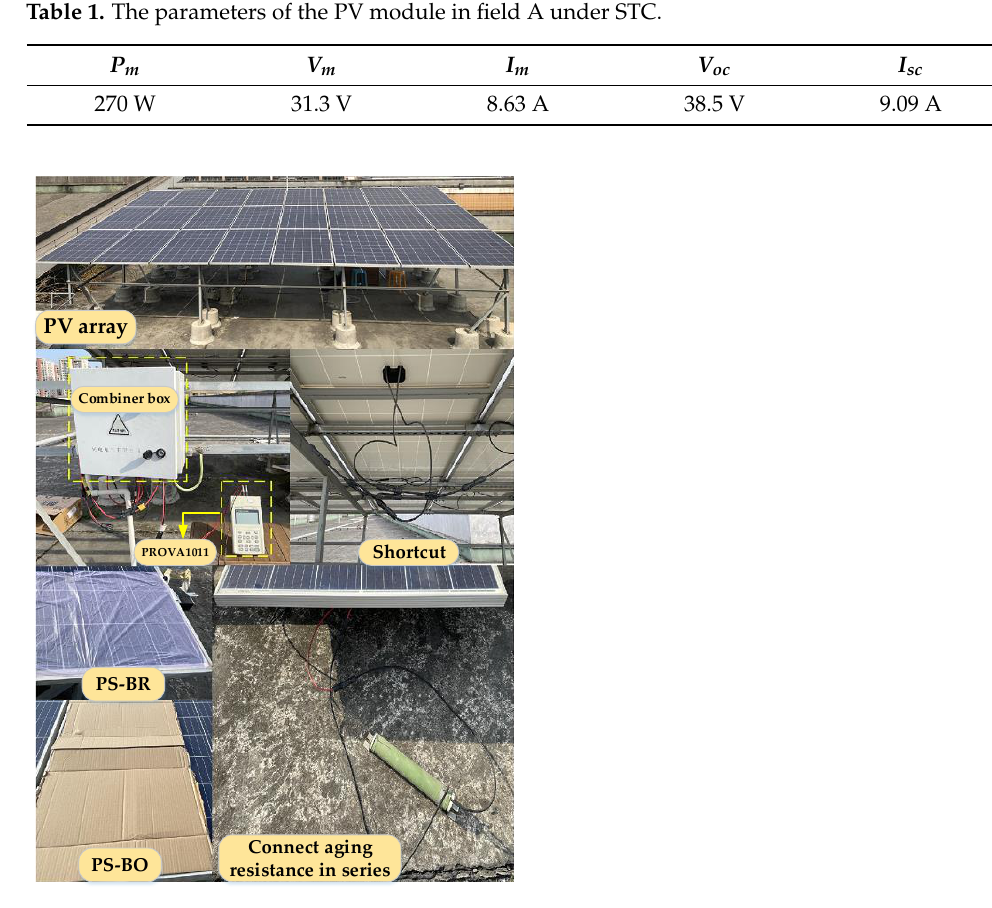
Figure 5. PV experimental field. Table 2. Summary of measured experimental fault